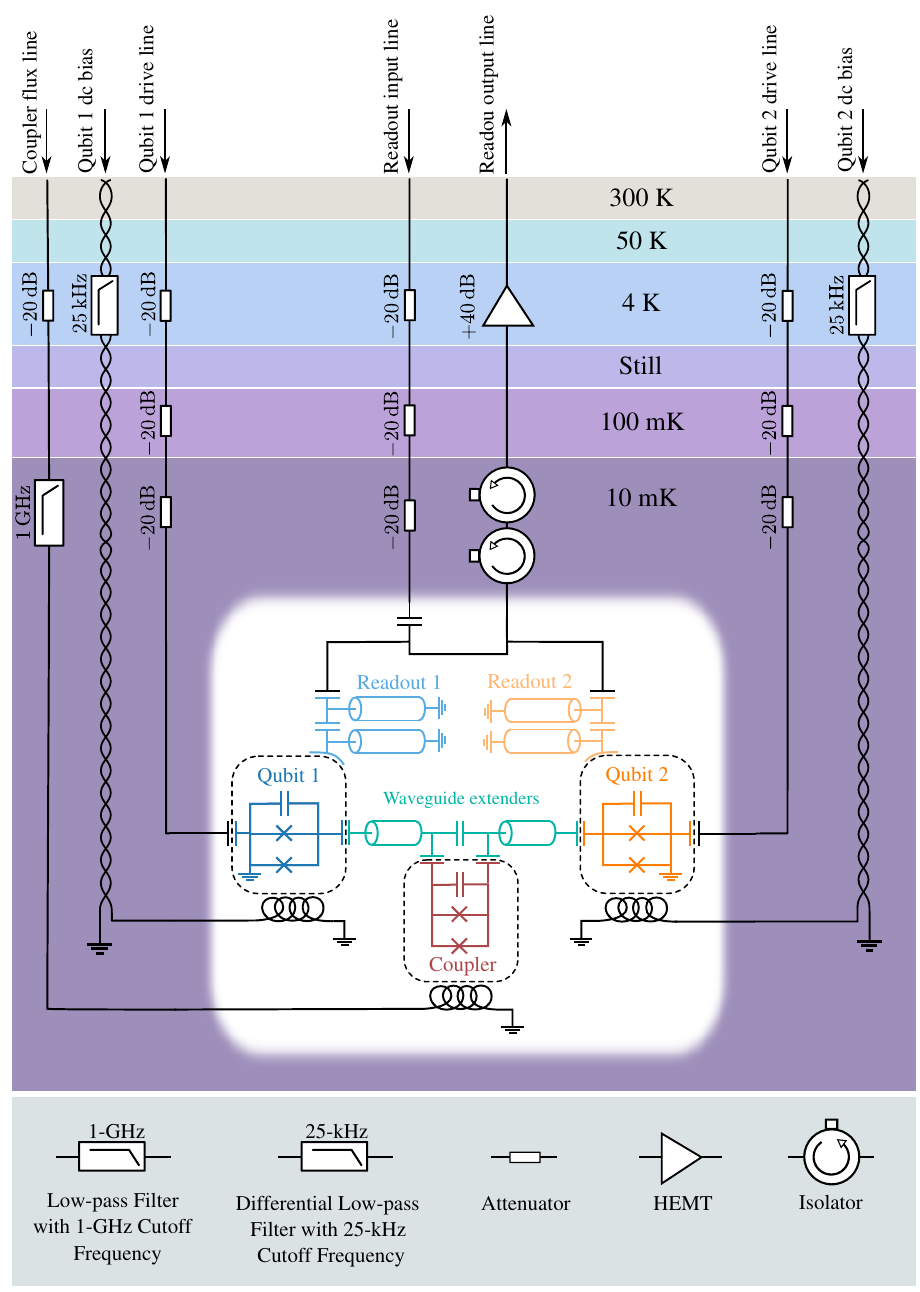
FIG. 9. The experimental setup. The background colors depict the different temperature stages of the dilution refrigerator. The coaxial microwave cables (straight black lines) and twisted-pair cables (braided lines) are used to control and read out the qubit and coupler states. The schematic of the sample in the white box consists of two flux-tunable qubits (blue and orange), a readout structure for each qubit (light blue and light orange), and a flux-tunable coupler (red). quadrature (IQ) mixing to the qubit frequency via the Ana- lines attenuated by a total of 60 dB throughout the different log Devices HMC8193 mixer is provided by a Rohde & temperature stages. The 20-dB attenuators are thermal- Schwarz SGS100A microwave generator. To control the ized at the corresponding temperature stages, as shown in frequency of each qubit, a voltage source at room tem- Fig. 9. The pulse envelopes for the qubit drives are gener- perature is connected to a twisted-pair cable that reaches ated by a Zurich Instruments HDAWG arbitrary-waveform down to the 10-mK stage. One conductor of the twisted generator HDAWG and the carrier for the in-phase and